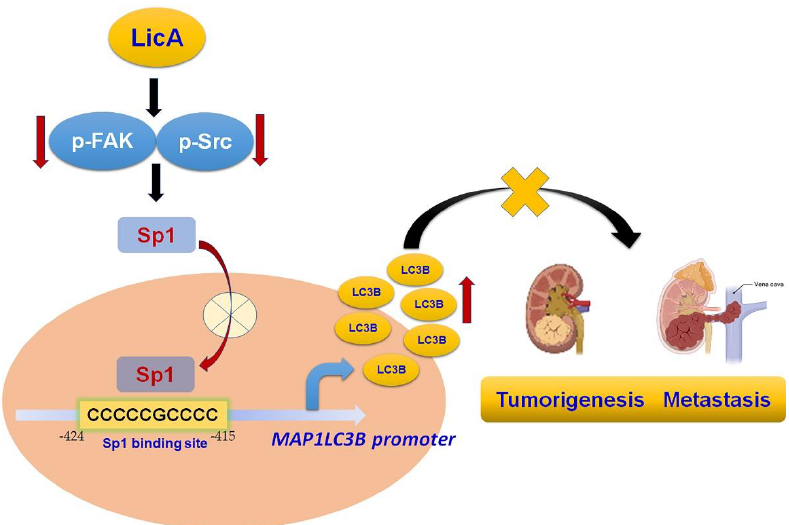
Figure 8. LicA inhibits RCC tumorigenesis and metastasis via the downregulation of the phosphoryl-Src/-FAK pathway. It does so by decreasing the Sp1 transcription activity, resulting in suppressed LC3B expression.